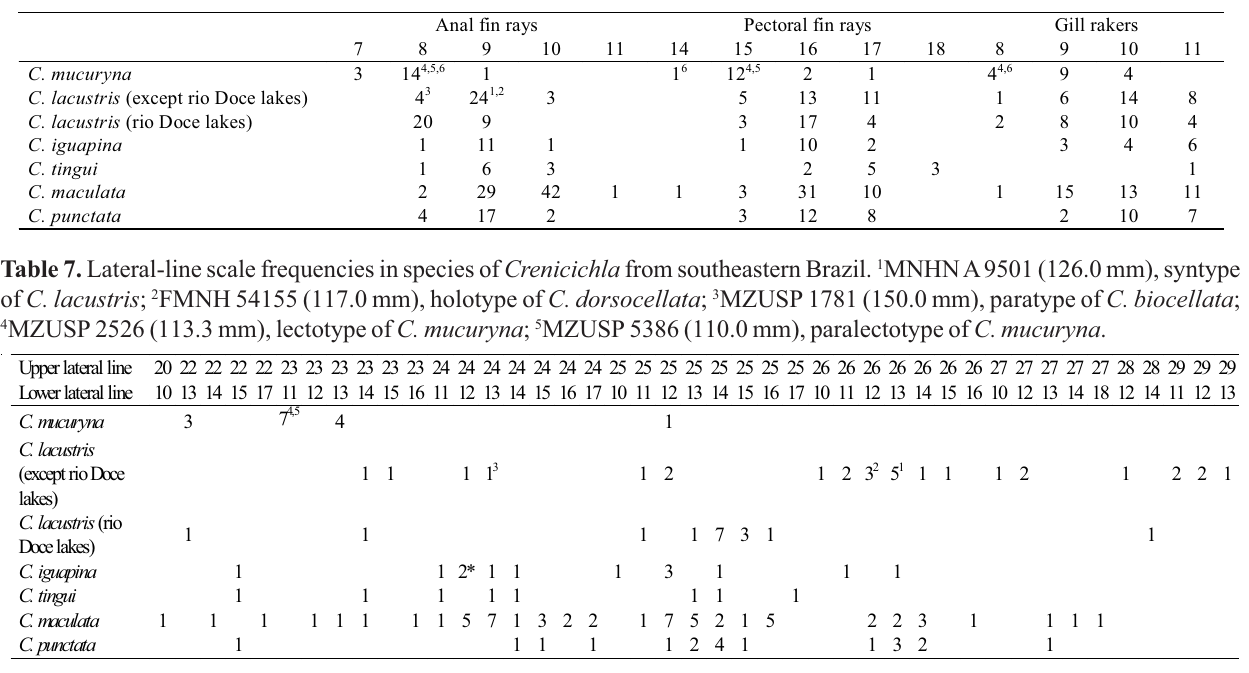
Table 6. Anal fin, pectoral fin, and gill rakers count frequencies in the species of Crenicichla from southeastern Brazil. 1 MNHN A9501 (126.0 mm), syntype of C. lacustris ; 2 FMNH 54155 (117.0 mm), holotype of C. dorsocellata ; 3 MZUSP 1781 (150.0 mm), paratype of C. biocellata ; 4 lectotype of C. mucuryna (113.3 mm); 5 MZUSP 5385), paralectotype of C. mucuryna (69.0 mm);